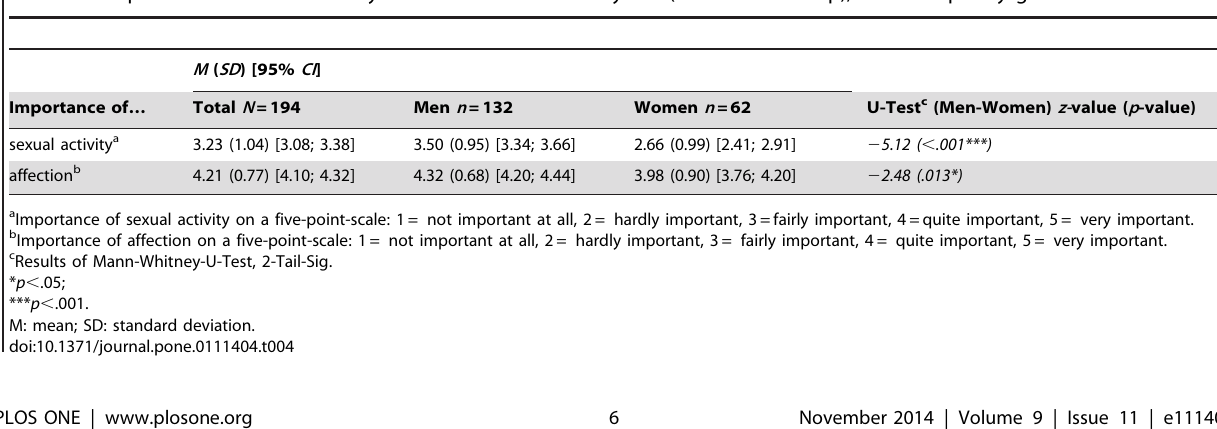
Table 4. Importance of sexual activity and affection at MP 74 years (second follow up); total sample by gender.